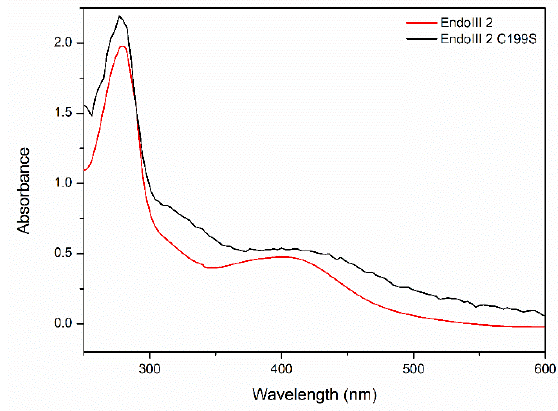
Figure 7. UV-vis spectra of DrEndIII2 and DrEndoIII2 C199S.